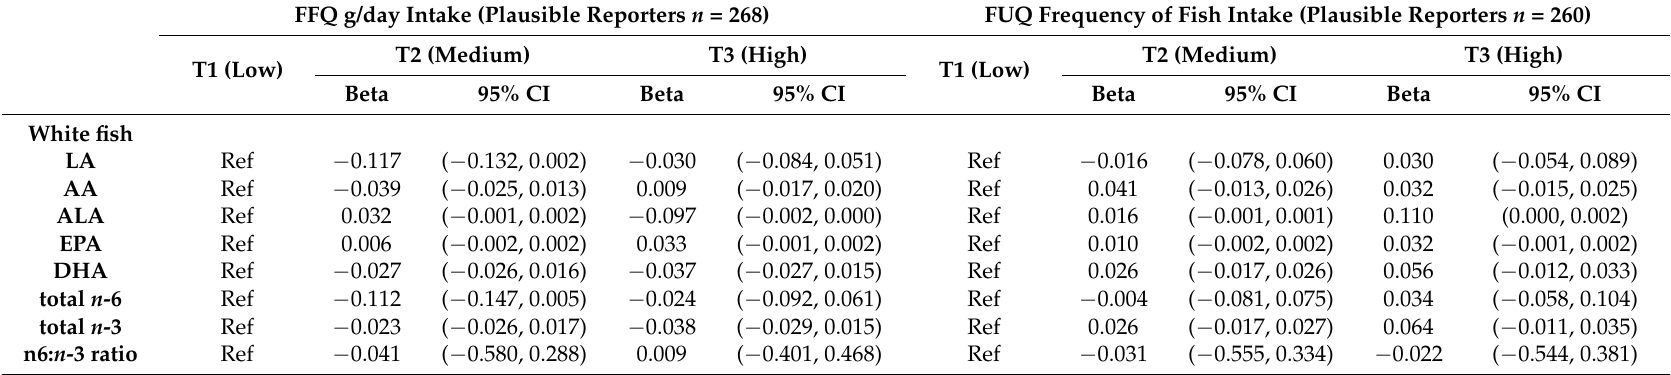
Table 5. Association between serum PUFA status and tertiles (T) of fish intake (grams per day) for all reporters and plausible